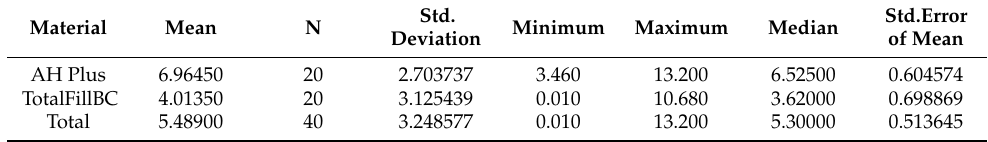
Table 3. Mean values and SD of the volume (in mm 3 ) of root canal filling in the two experimental groups and root canal remnants after root canal retreatment were determined by micro-CT analy- sis. Material Mean N Std. Deviation